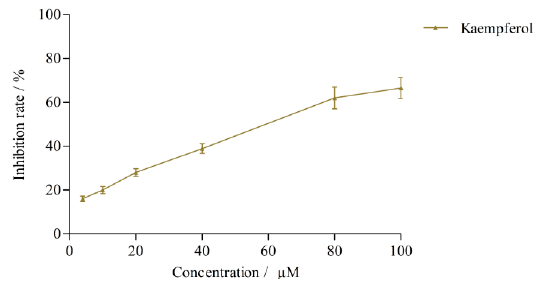
Figure 5. Effect of kaempferol on CYP2E1 isozyme activity. Table 3. Effects of flavonoids on CYP2E1 isozyme activities ( x ˘ s, n = 3).